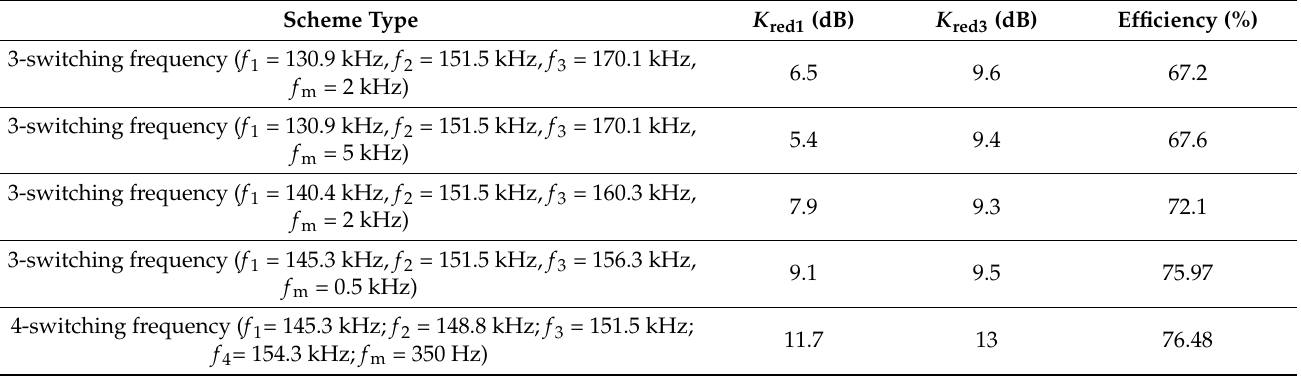
Table 3. Radiated emission reduction coefficients and the efficiency of the WPT system under the measurements with three-switching-frequency technique used. Note: when f m = 2 or 5 kHz, then RBW was chosen to be 1 kHz; when f m = 0.5 or 0.35 kHz, then RBW = 0.1 kHz.